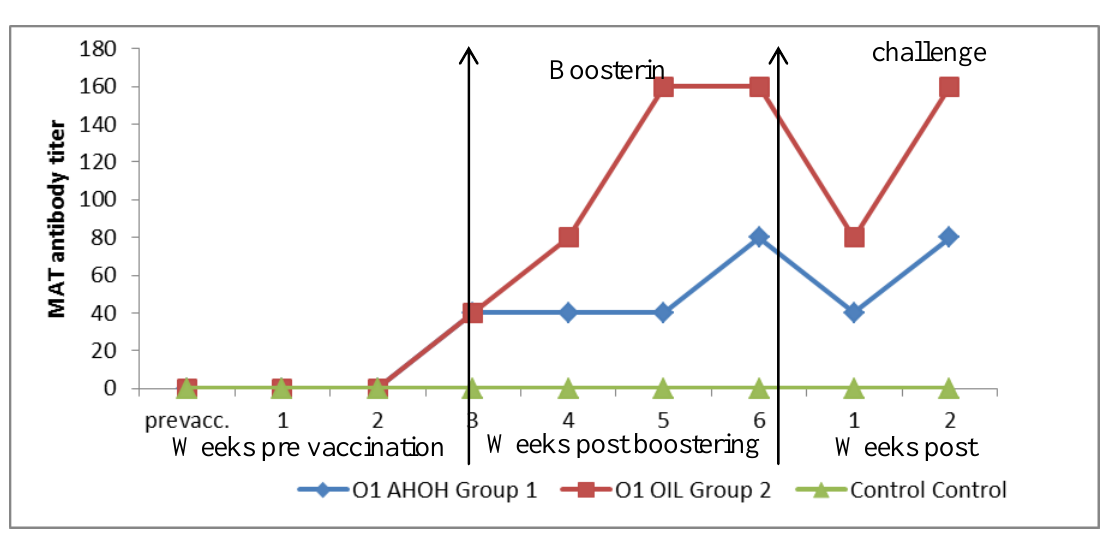
Fig.1 : Microagglutination titer in sera of vaccinated turkey poults using O1 antigen and challenged with E.coli serotype